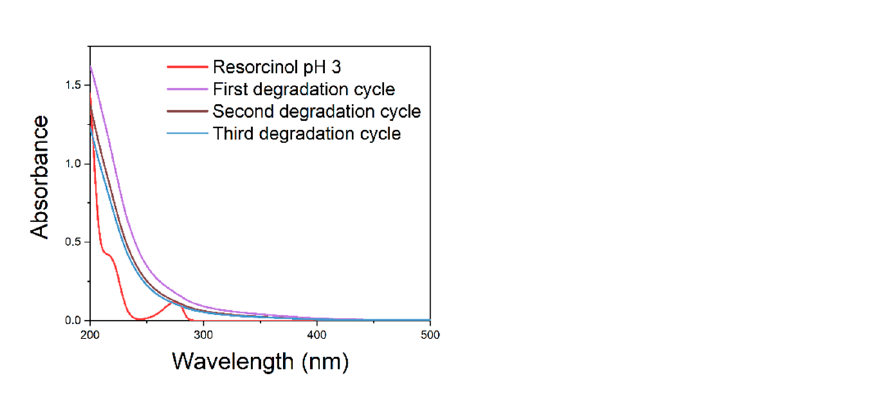
Figure 5. UV–vis spectra of Fenton-processed resorcinol solution using the catalyst after regeneration with hydroxylamine hydrochloride.